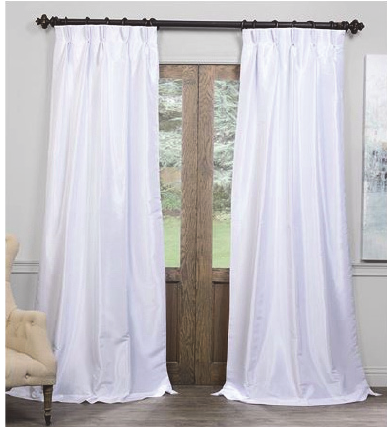
Figure 3: Preoperative mucosal prolapse.